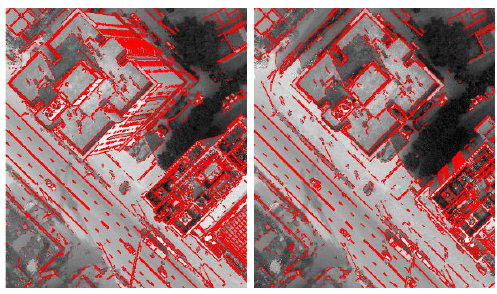
Fig. 10. Patch #2 - LSD: 4550 and 3475 lines extracted